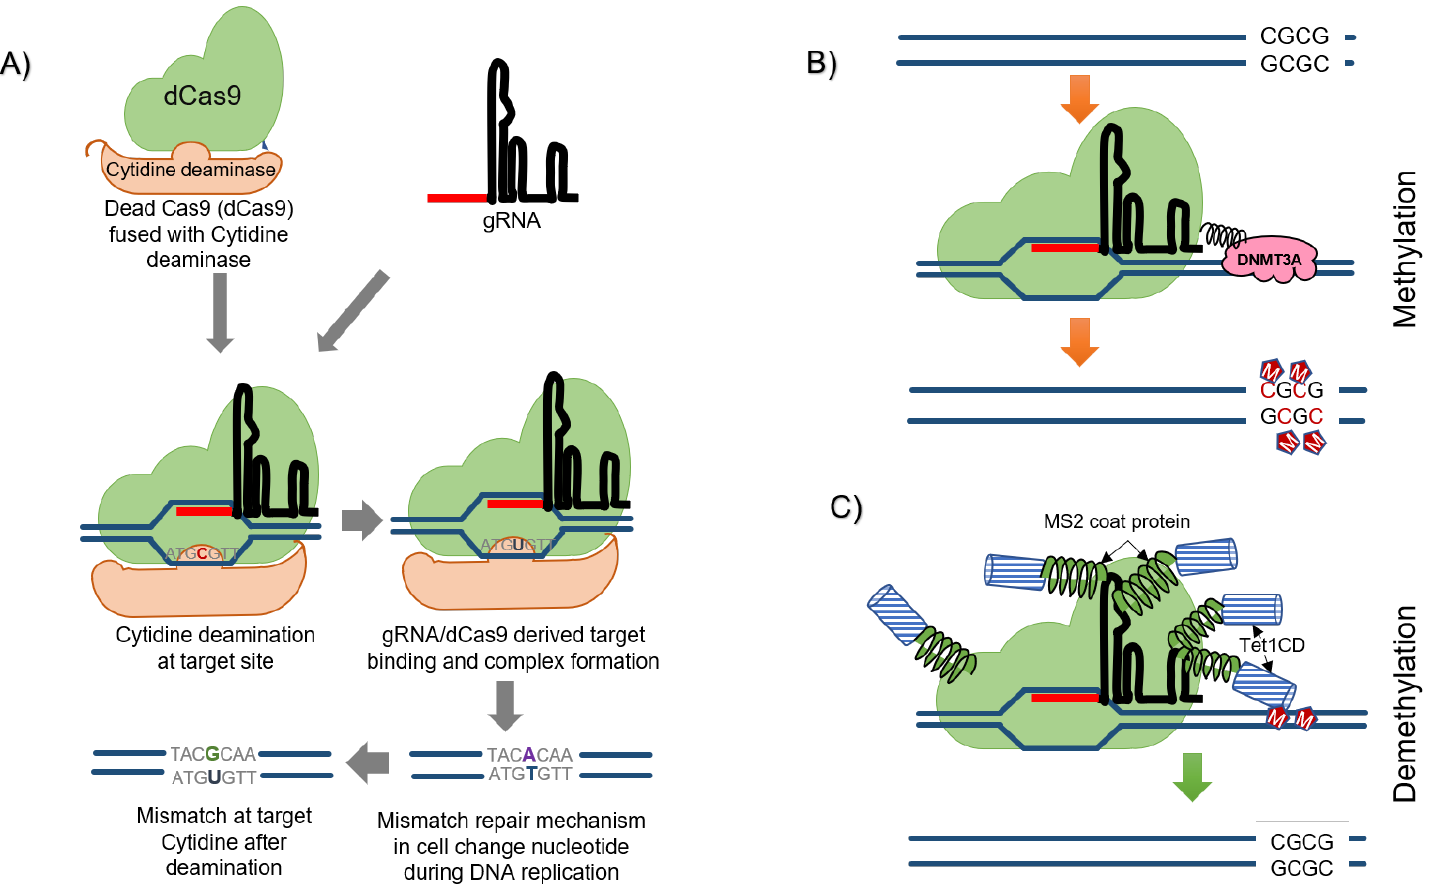
Figure 7. ( A ) Precision base editing by utilizing cytidine deaminase fused with dCas9. With the help of guide RNA (gRNA), Cas9 make complex at a specific target site and then the cytidine deaminase act on cysteine present on the opposite strand. The deamination process converts cysteine (C) to uracil (U) which later gets converted into adenine-thymine base-pair during DNA replication by the inbuilt mismatch repair mechanism. ( B , C ) CRISPR mediated methylome editing. Dead Cas (dCas) is fused to a DNA methyltransferase (DNMT3A in case of animals) or a demethylase, such as ten-eleven translocation dioxygenase (tet) in animals, which can be used to edit the